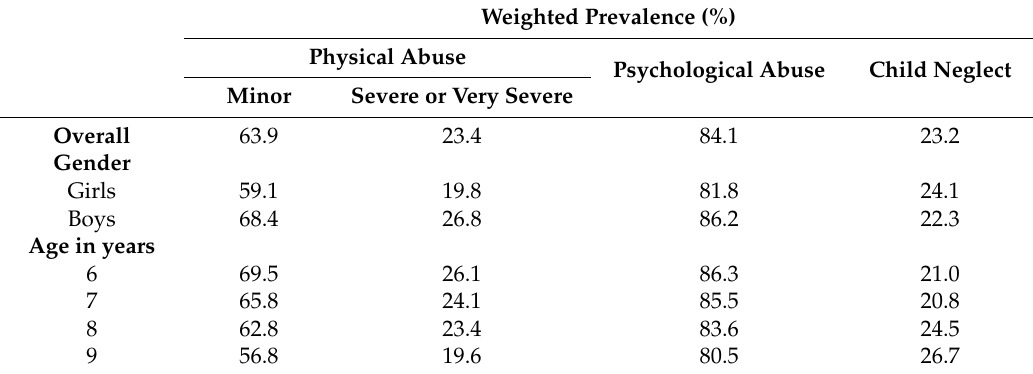
Table 2. Weighted prevalence of child